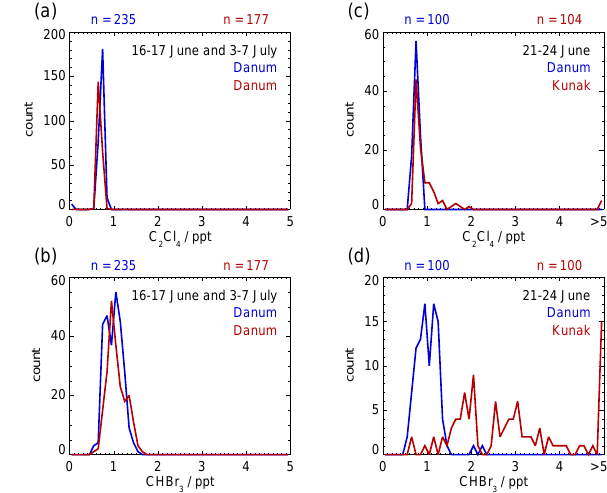
Fig. 3. Probability density functions (pdfs) for measurements made with µ -Dirac during OP3. One instrument remained at Bukit Atur, Danum Valley (blue). One instrument made measurements at Danum and at Kunak (red). (a) and (b) show, respectively, C 2 Cl 4 and CHBr 3 measurements made while the instruments were co- located. (c) and (d) show measurements made while the instruments were at different sites. For each plot 0.1ppt bins were used, and the number of measurements made by each instrument ( n ) is indicated